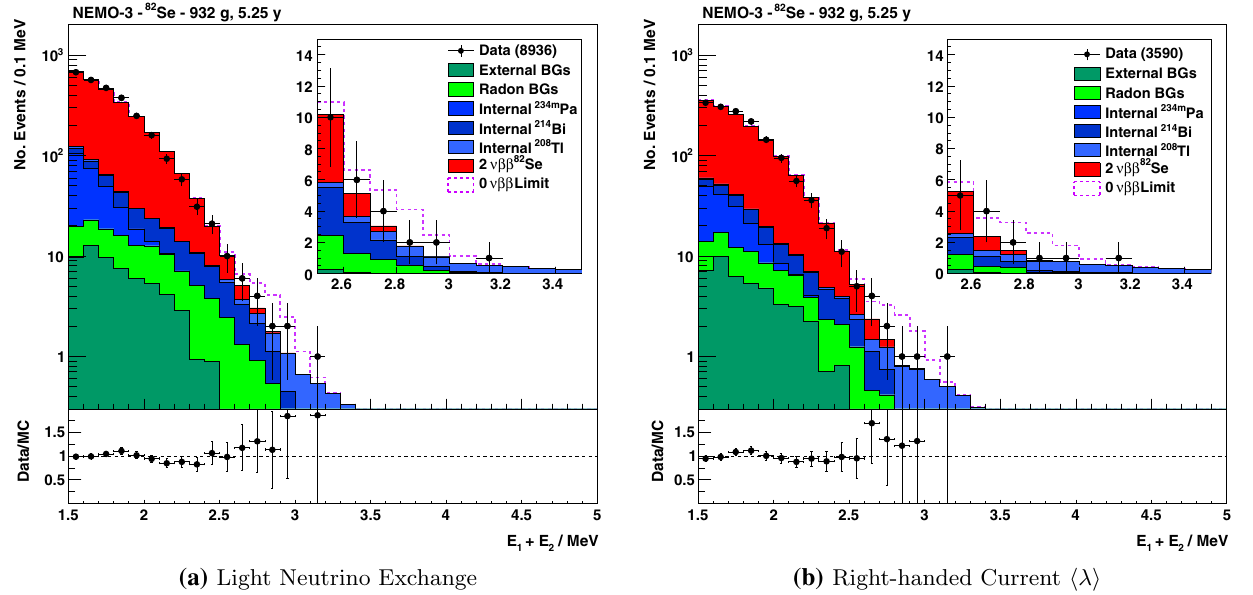
at 90% C.L. a contains events selected in the ββ channel and b contains a subset of these events that also pass the energy asymmetry cut for the right-handed current (cid:2) λ (cid:3) mode, A > 0 . 26, where A is defined in the